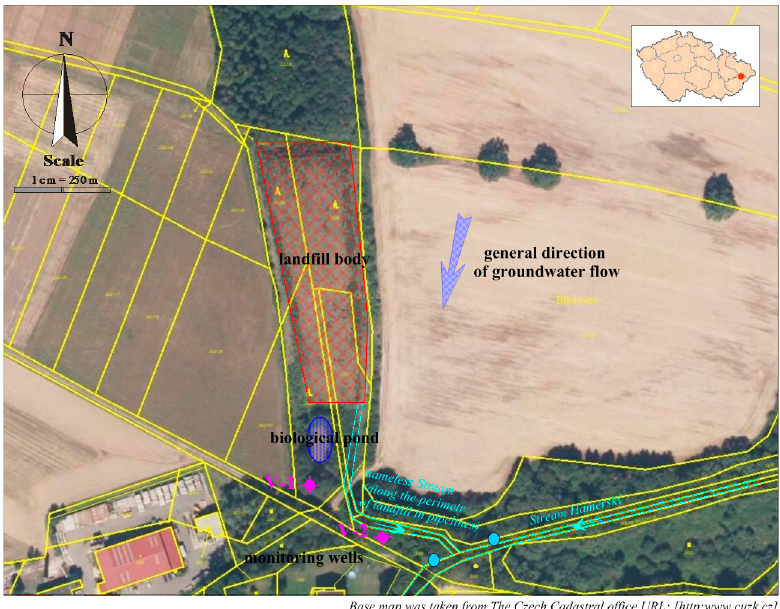
Figure 1. Description of the landfill situation with the monitoring system.